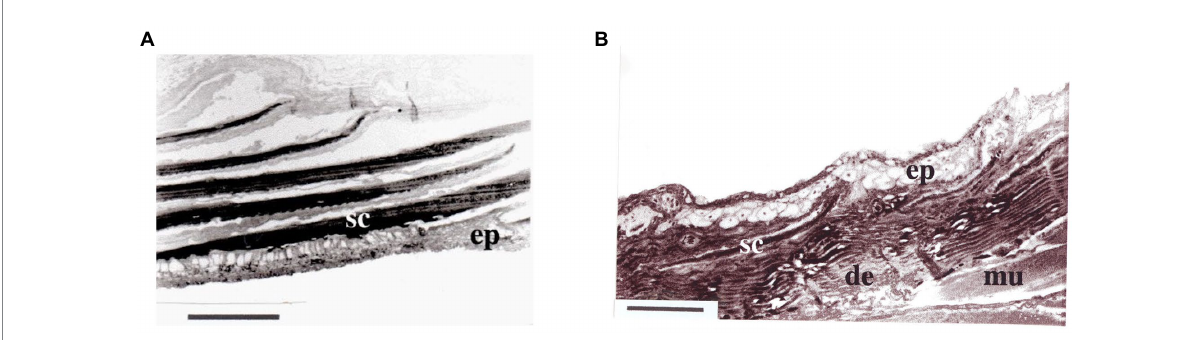
FIGURE 3 Examples of variation in scale counts from different species of mudskipper from Zhang (2001). Images depict the (A) , transverse section of the operculum of Periophthalmodon septemradiatus (not included in this study) and (B) , lateral side of the caudal peduncle of Scartelaos histophorus . sc, scales; ep, epidermis; de, dermis; mu, muscle. Scale bars indicate 100 μ m. Pn. septemradiatus has continuous multilayered scales, whereas S. histophorus has isolated embedded